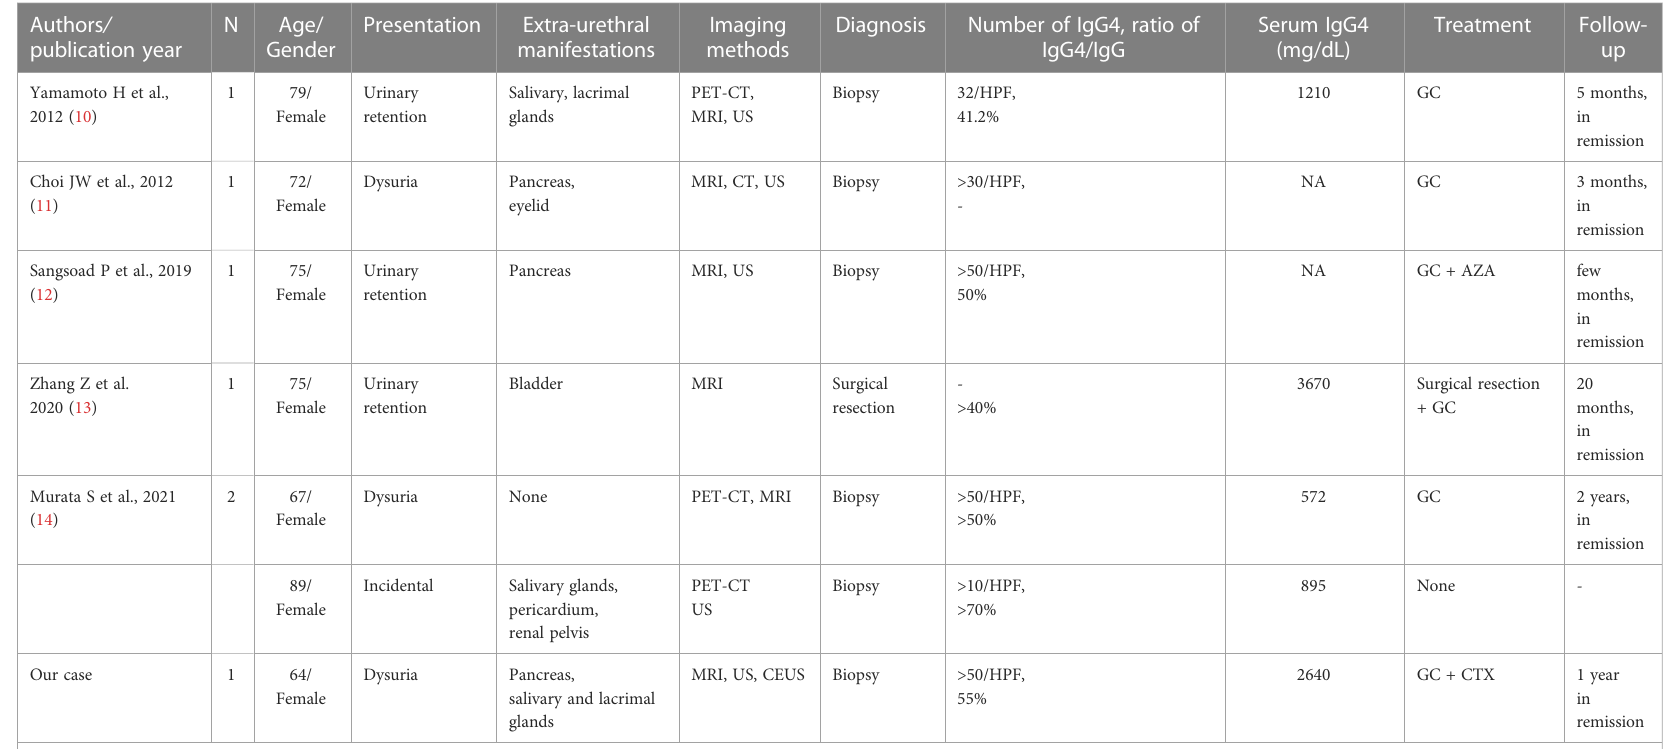
TABLE 1 Published reports of IgG4-RD patients with urethral